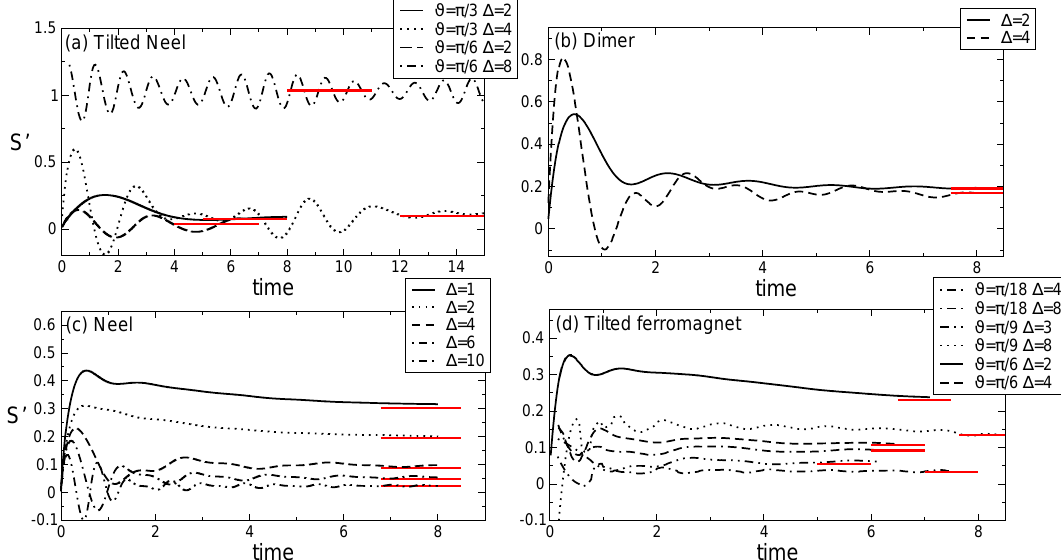
Figure 8: Entanglement production rate after a global quench in the XXZ spin chain. The panels plot S (cid:48) ( t ) as function of time. Different panels are for different initial states, namely the tilted Néel state (a), the dimer state (b), the Néel state (c), and the tilted ferromagnet (d). The curves are iTEBD numerical data for different anisotropy ∆ and different tilting angles ϑ . The horizontal segments are the predictions using the quasiparticle picture in the scaling